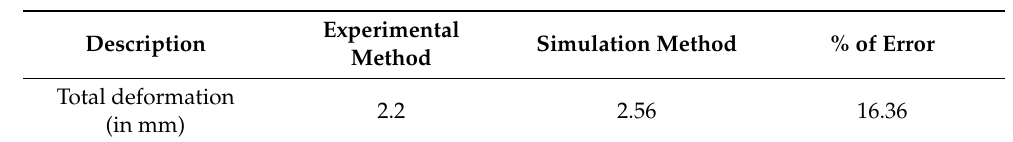
Figure 15. Total Deformation. Table 12. Comparative